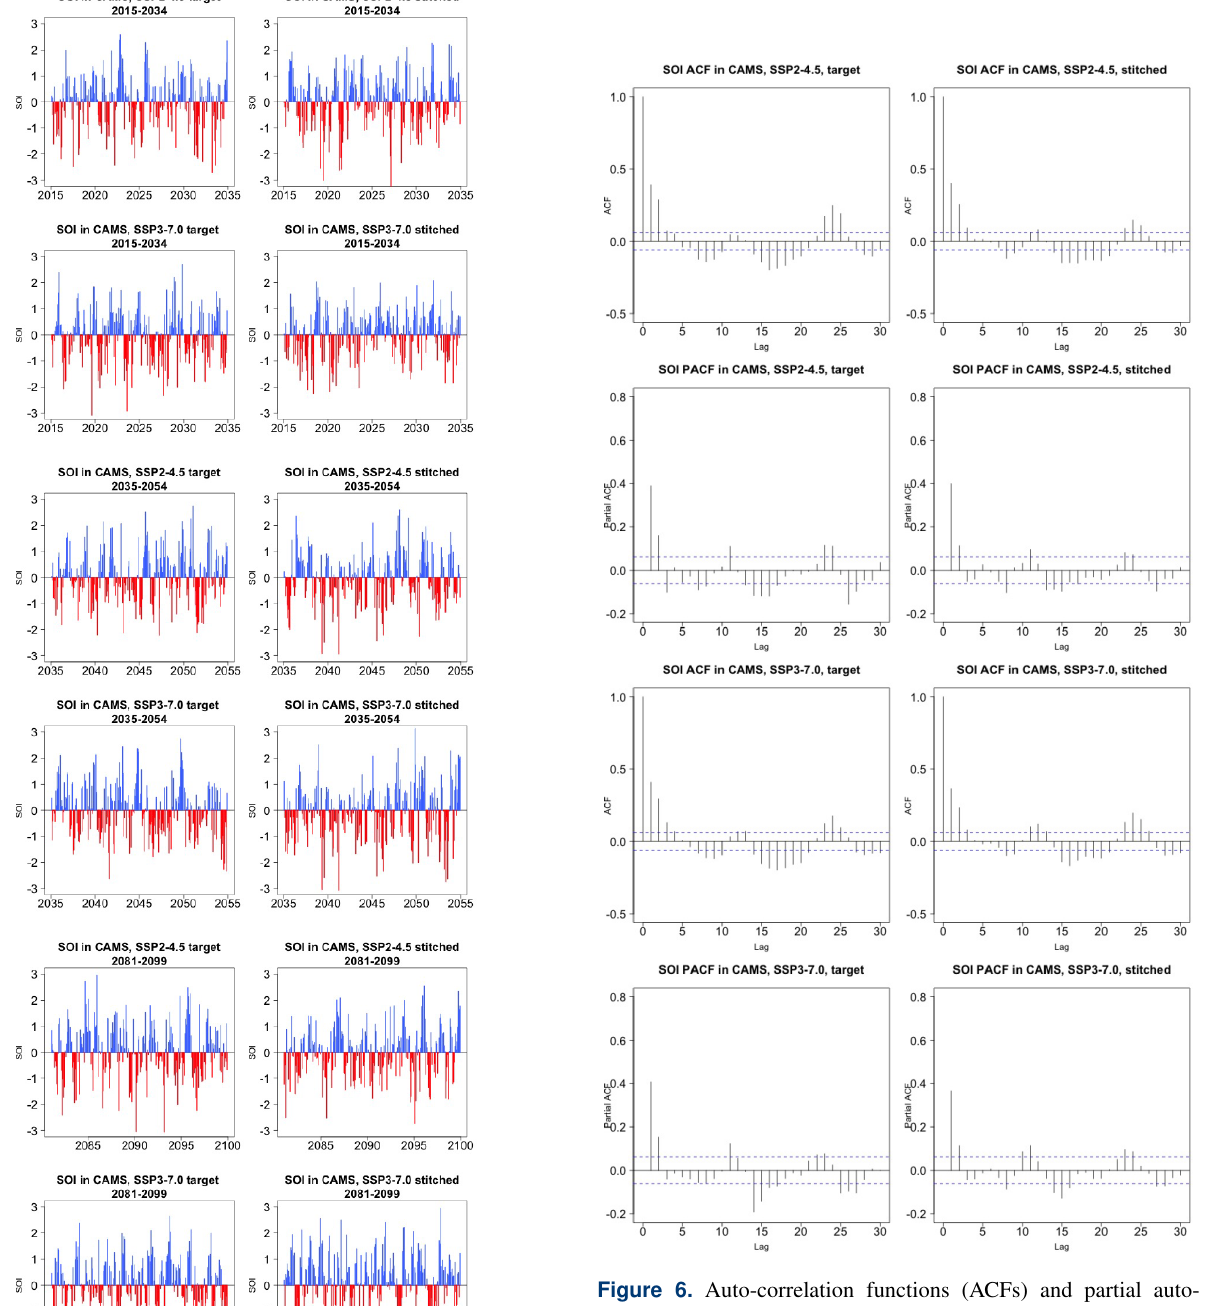
Figure 6. Auto-correlation functions (ACFs) and partial auto- correlation functions (PACFs) for real and stitched SOI time series. Top two rows: SSP2-4.5 ACF for target and stitched series and re- spective PACFs. Bottom two rows: SSP3-7.0 ACF for target and stitched series and respective PACFs. (Our software – R function acf(..,type="partial") – does not define the PACF at lag